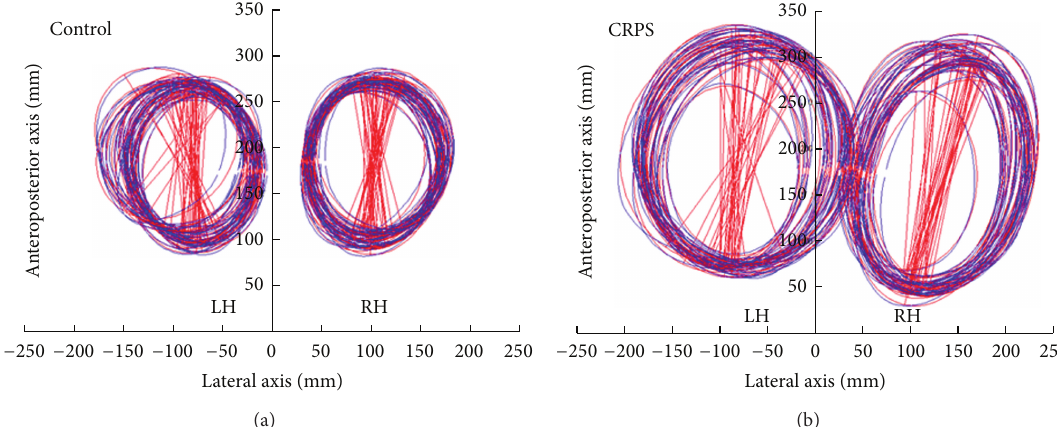
Figure 2: Circle drawing task. Example of circle drawing task for a control (a) and a patient (b). LH: left hand; RH: right hand. The blue tracks depict the actual drawing performed by the subject with the left hand (LH) or right hand (RH), whereas the red tracks represent the ellipses fitted to the drawing. The red straight lines depict each ellipse main axis, showing a limited variability in orientation and size. Note that the neglect-like prediction that the left affected hand produces smaller circles is not verified in this representative